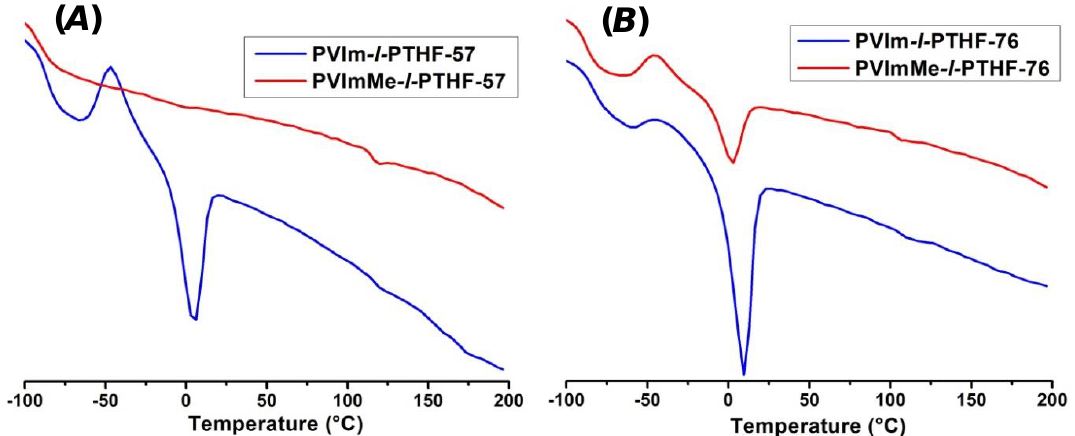
Figure 3. DSC curves of the PVIm- l -PTHF-57 ( A ) and PVIm- l- PTHF-76 ( B ) (blue lines) and the methylated PVImMe- l -PTHF-57 ( A ) and PVImMe -l -PTHF-76 ( B ) poly(ionic liquid) (red lines) conetworks. Table 1. The composition of the PVIm- l- PTHF and PVImMe- l- PTHF conetworks, yield of alkylation, the glass transition temperature ( T g ) of the PTHF, PVIm, and PVImMe + I − components, the melting temperature ( T m ) and crystalline fraction ( X c ), the d -spacing, the average domain sizes ( d PTHF , d PVIm , and d PVImMe ), and the average domain distances in the corresponding PVIm -l- PTHF and PVImMe -l- PTHF conetworks. PVIm- l -PTHF-57 PVImMe- l -PTHF-57 PVIm -l -PTHF-76 PVImMe- l -PTHF-76 PTHF content (wt%) PVIm content (wt%) 43 PVImMe + I − content (wt%) 62 T g of PTHF ( ◦ C) (a) − 86 − 89 − 83 − 87 T g of PVIm and PVImMe ( ◦ C) (b) 116 T m of PTHF ( ◦ C)